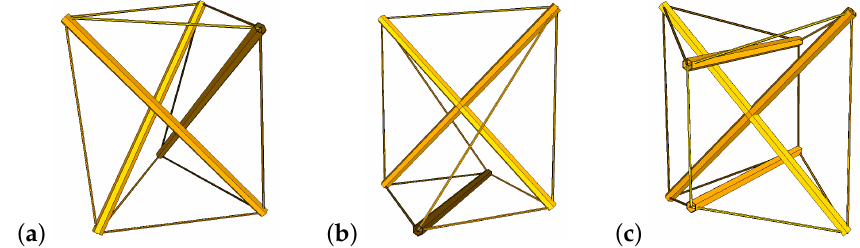
Figure 1. Regular tensegrity modules: ( a ) three-strut simplex; ( b ) X-module; ( c ) expanded octahedron.